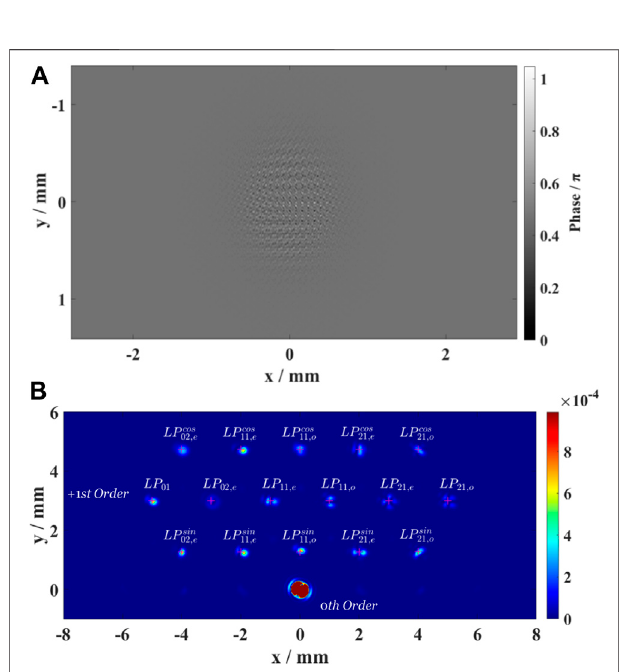
FIGURE 3 | (A) An angular multiplexing computer-generated hologram involving 16 transmission functions, which are the complex conjugates of LP 01 , LP 11 e , LP 11 o , LP 02 , LP 21 e , LP 21 o , LP cos 11 e , LP cos 11 o , LP cos 02 , LP cos 21 e , LP cos 21 o , LP sin 11 e , LP sin 11 o , LP sin 02 , LP sin 21 e , and LP sin 21 o , respectively. There are three transmissionfunctionsforonemodeMD (exceptforfundamentalmode LP 01 ): one for measuring the modal weight and the other two for measuring the intermodal phase. (B) Simulation of the far- fi eld diffraction spatial spectrum of the preset optical fi eld. + (violet) denotes the centroid of the +1st diffraction order spot. The 0th diffraction order spot is saturated since it is much brighter than the other spots in the +1st diffraction